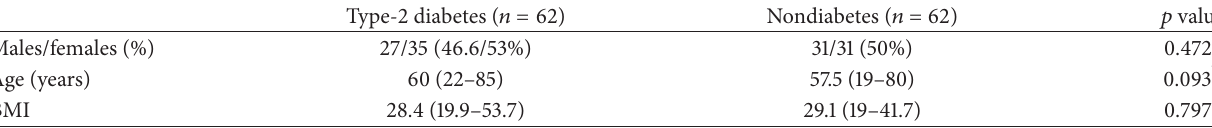
Table 1: Demographic characteristics of patients.